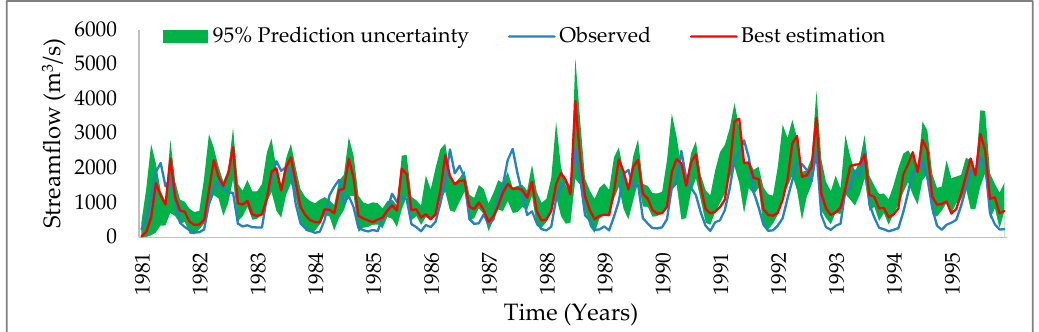
Figure 4. Comparison of simulated flow with the observed flow without considering elevation bands (calibration).